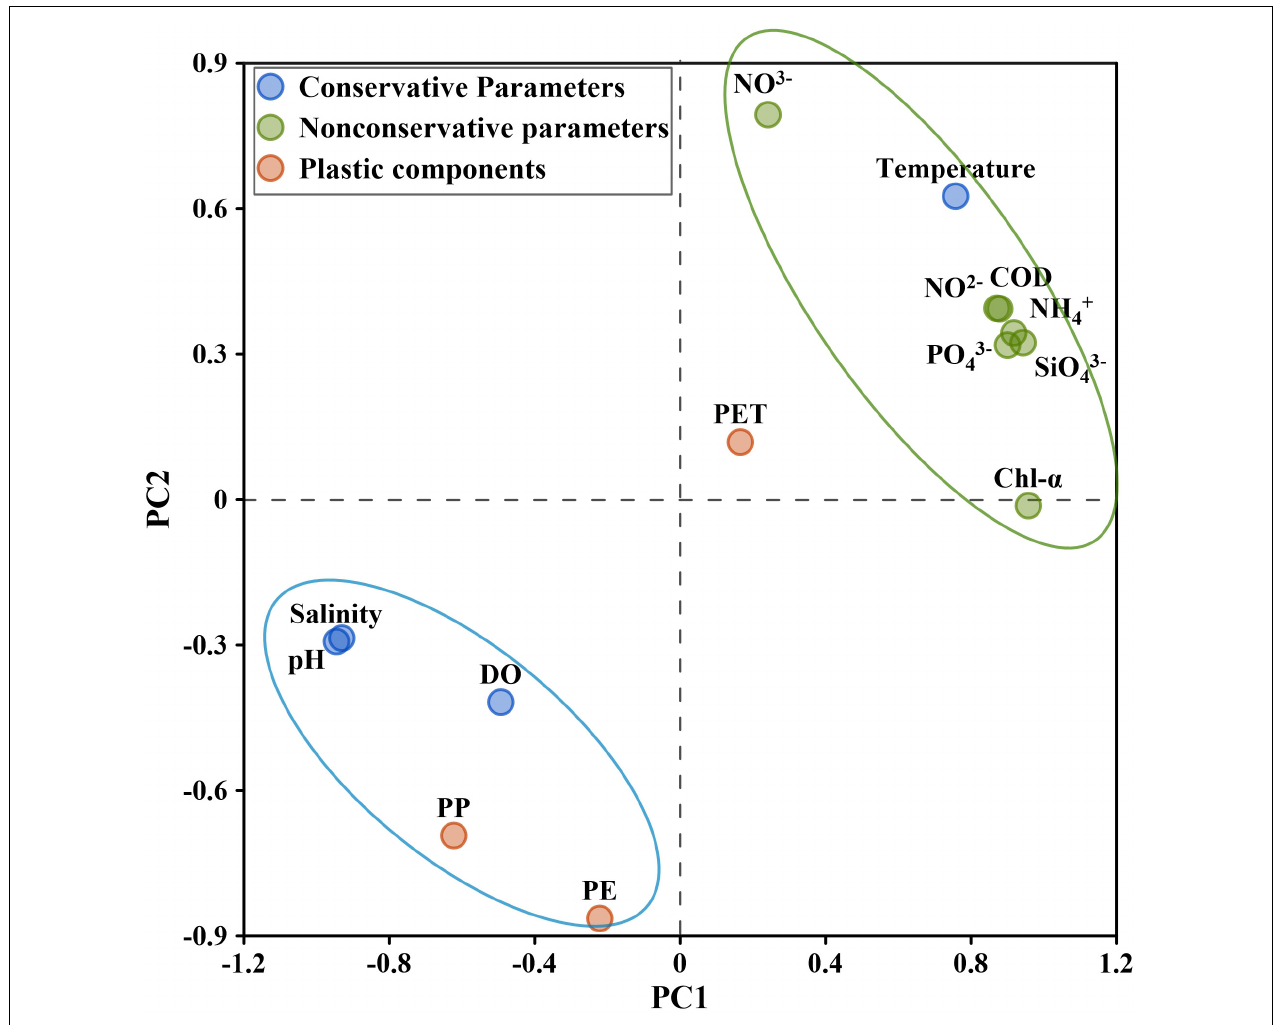
FIGURE 4 | Loadings of microplastic parameters on principal component 1 (PC1) and principal component 2 (PC2). The parameters were classified into 3 types: conservative (such as temperature and salinity), nonconservative (such as nutrients), and plastic components (including PET, PP, and